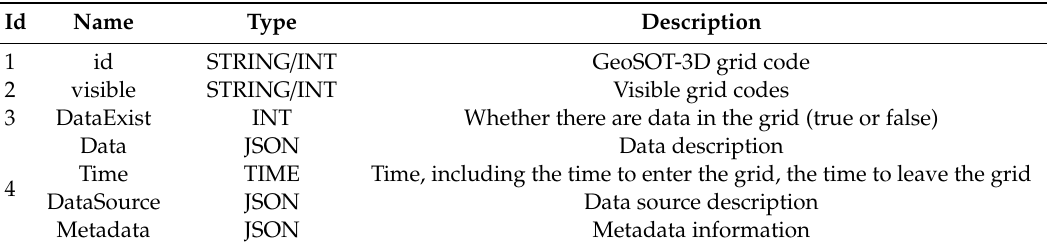
Table 2. Structure of Aerospace grid indexing BigTable.